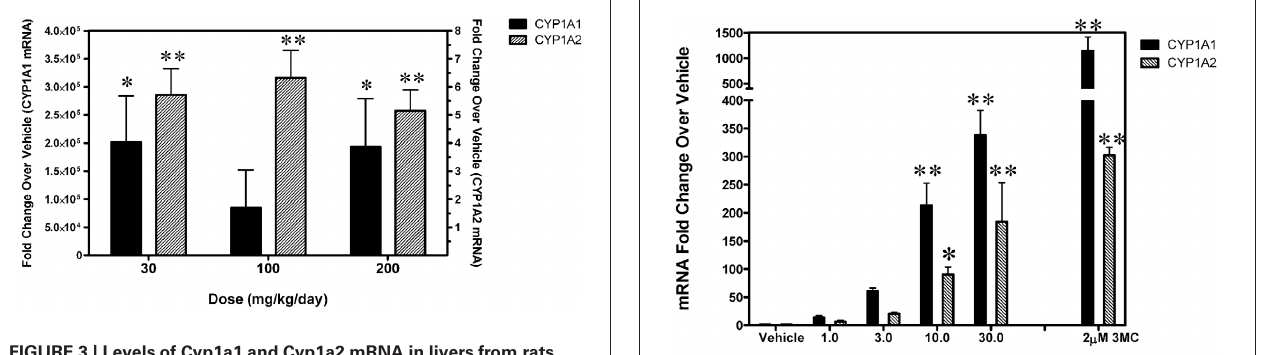
FIGURE 3 | Levels of Cyp1a1 and Cyp1a2 mRNA in livers from rats dosed for 5 days with 30, 100, or 200mg/kg/day A-998679compared to vehicle control animals. The solid black bars represent Cyp1a1 levels (left y-axis) from an individual rat while the shaded bars represent Cyp1a2 levels (right y-axis). The mRNA data are expressed as fold-change (average ± SD) compared to vehicle. Asterisks indicate that the values were significantly different between treated and vehicle control rats ( ∗ p < 0 . 05, ∗∗ p < 0 . 001).